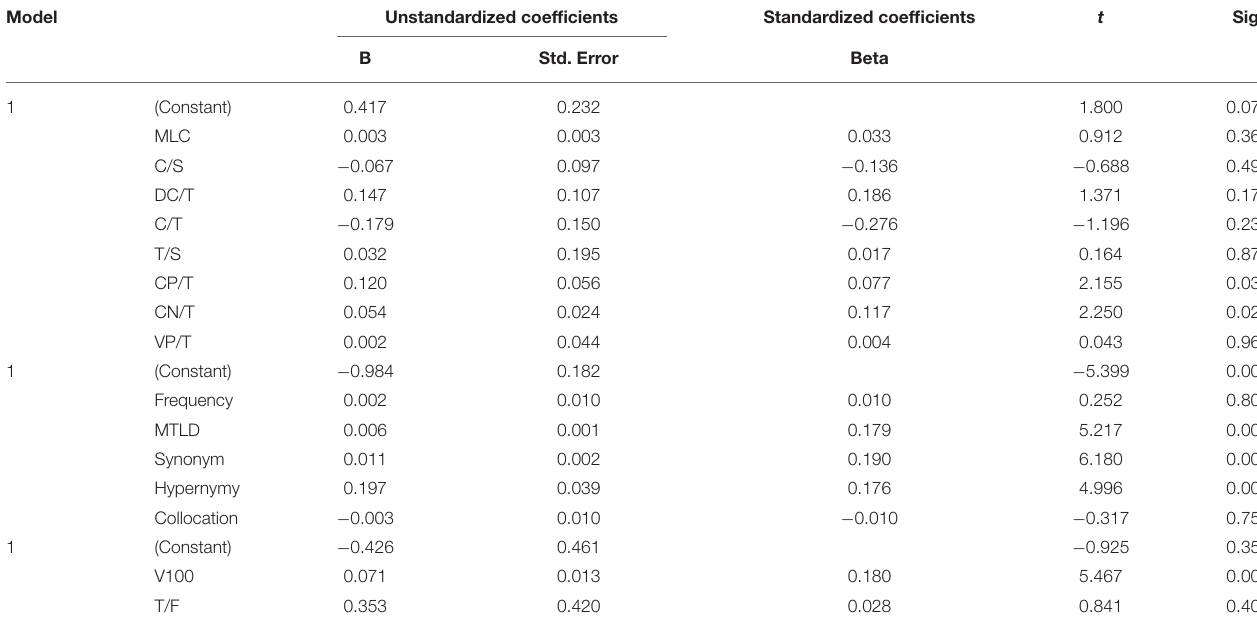
TABLE 5 | Coefficients a .